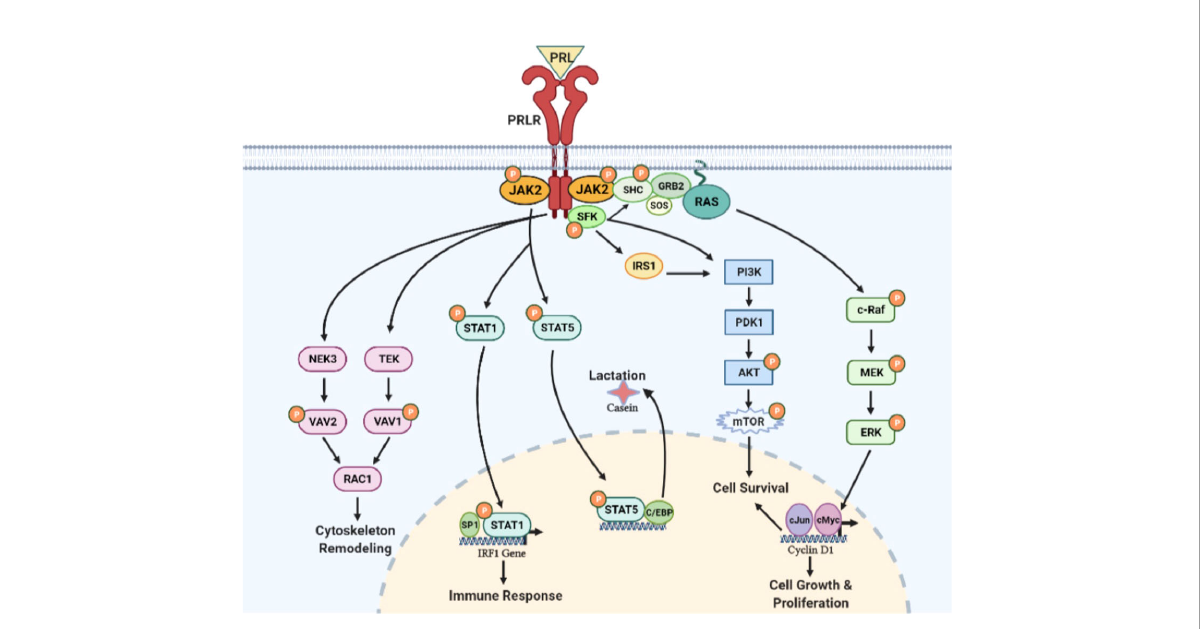
FIGURE 6 PRL/PRLR signaling pathways. PRL through its receptor PRLR induces multiple signaling cascades which include participation of JAK, SFK, PI3K/ AKT, NEK3/VAV2, TEK/VAV1 kinases and STAT transcription factors. These signaling pathways are involved in lactation, immune response, cytoskeleton remodeling and cell growth, proliferation & survival [adapted from reference